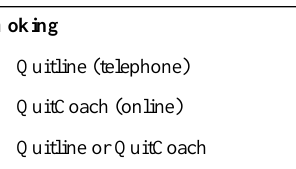
Signed up to support